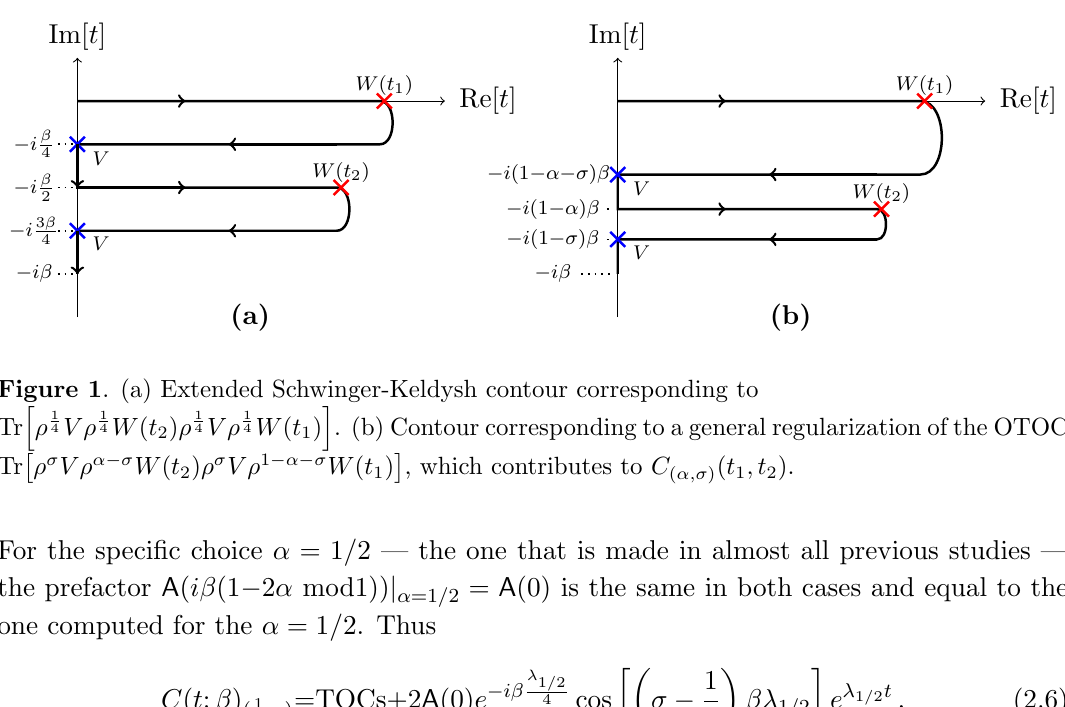
( t 1 ; t 2 ( (cid:11);(cid:27) )